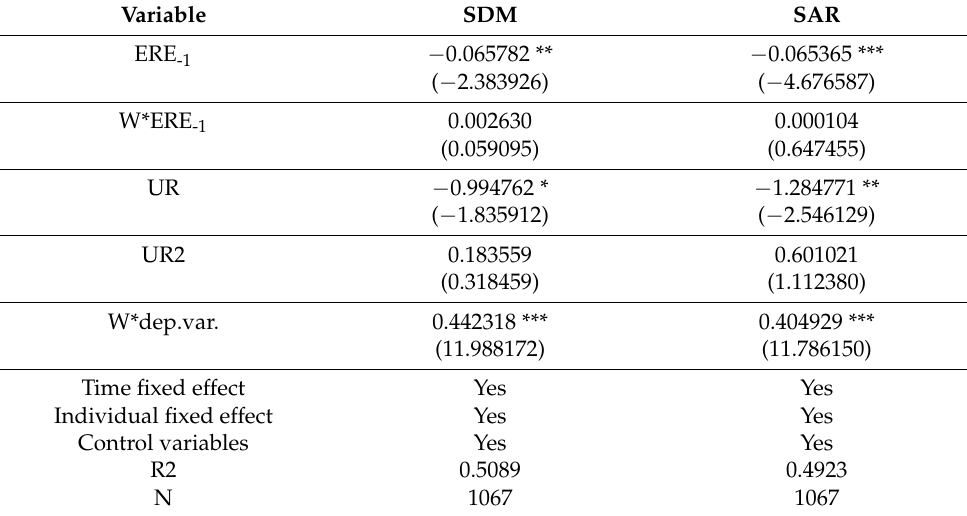
Table 8. Estimation results of dynamic SDM and